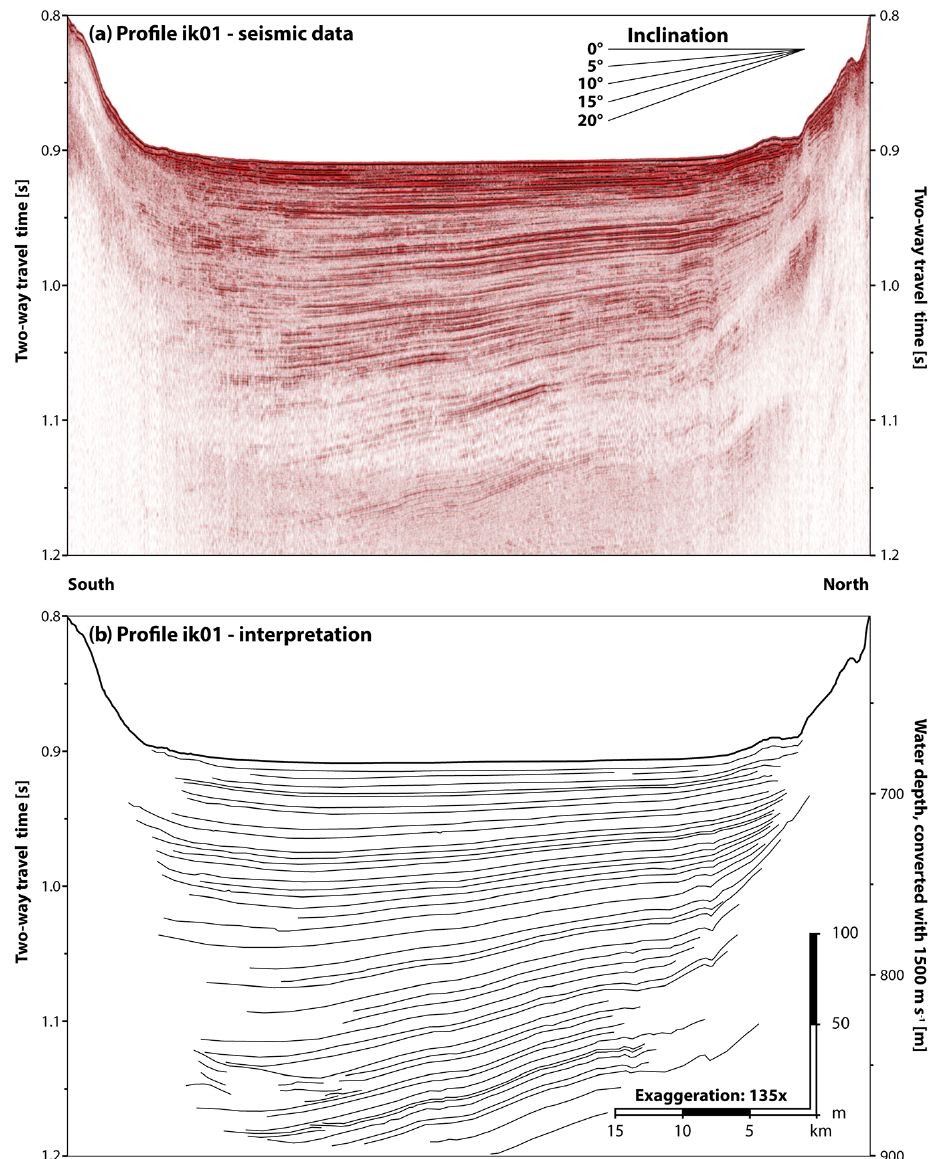
Figure 4. North–south profile ik01. The asymmetric nature of the lake basin is clearly visible with considerably higher subsidence rates towards